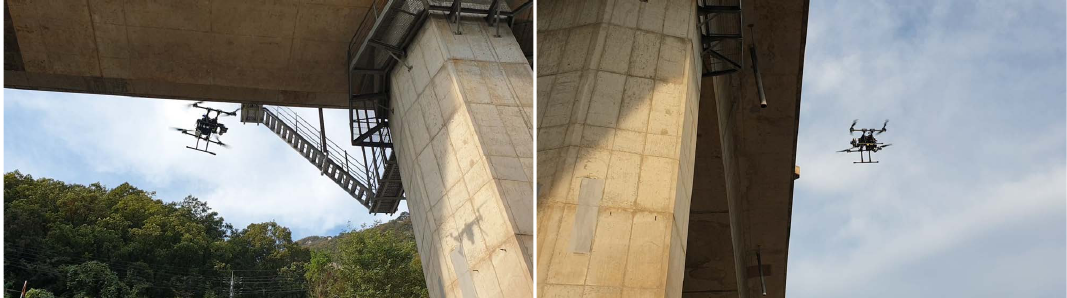
Figure 2. Autonomous bridge inspection in outdoor field tests: ( left ) bridge bottom part inspection; ( right ) bridge column